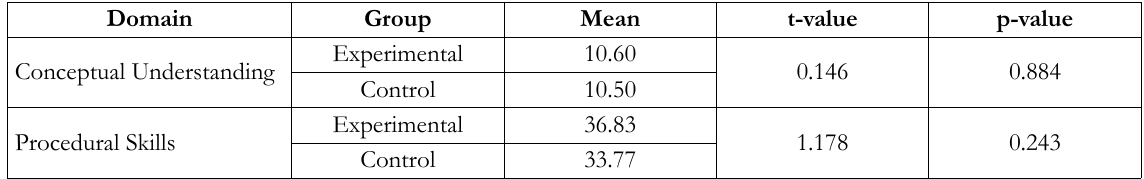
Table 4. Significant Difference in the Posttest Performances of the Experimental and Control